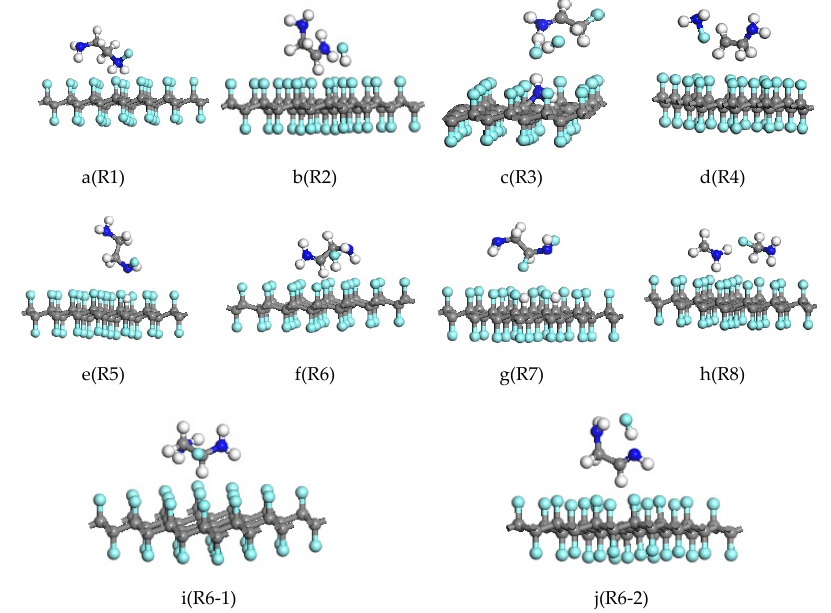
Figure 2. The structures of products of the reaction of the gauche structure ( a , b , c , d ) and the trans structure ( e , f , g , h ) of ethylenediamine with fluorinated graphene. ( i ) and ( j ) represent subsequent reactions of R6. Gray, blue, white, and cyan colors represent C, N, H, and F atoms, respectively.